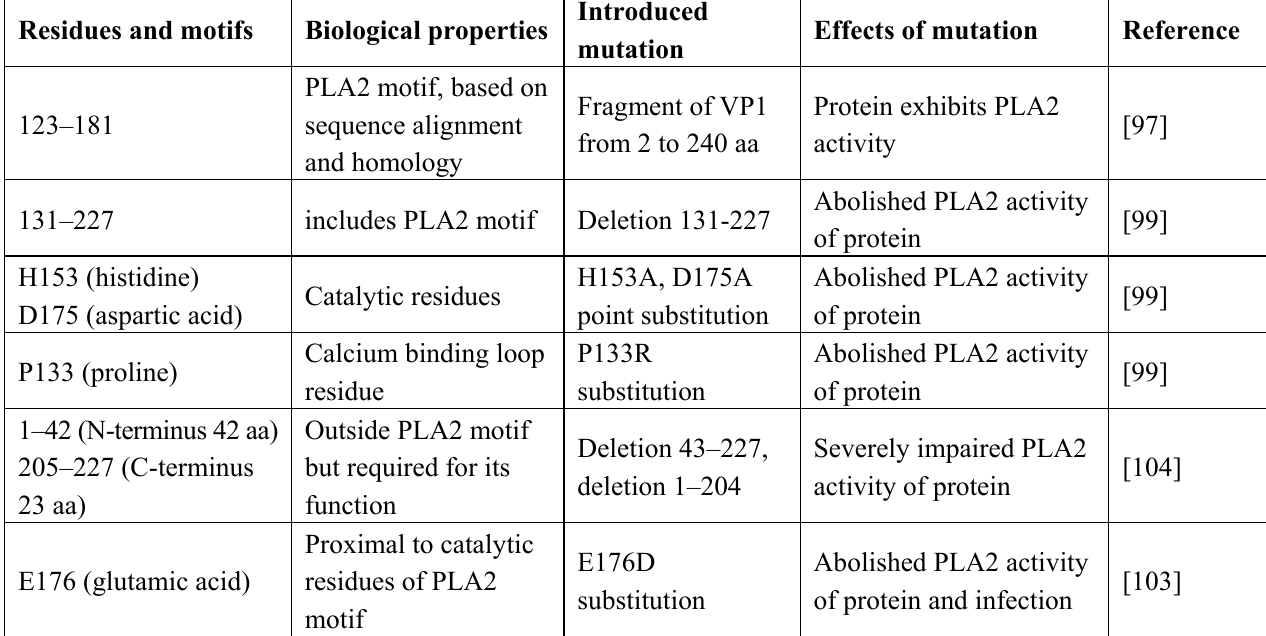
Table 1. Overview of sequence features of B19 VP1 unique region residues and motifs involved in endosomal escape. The biological effects of mutations are included if